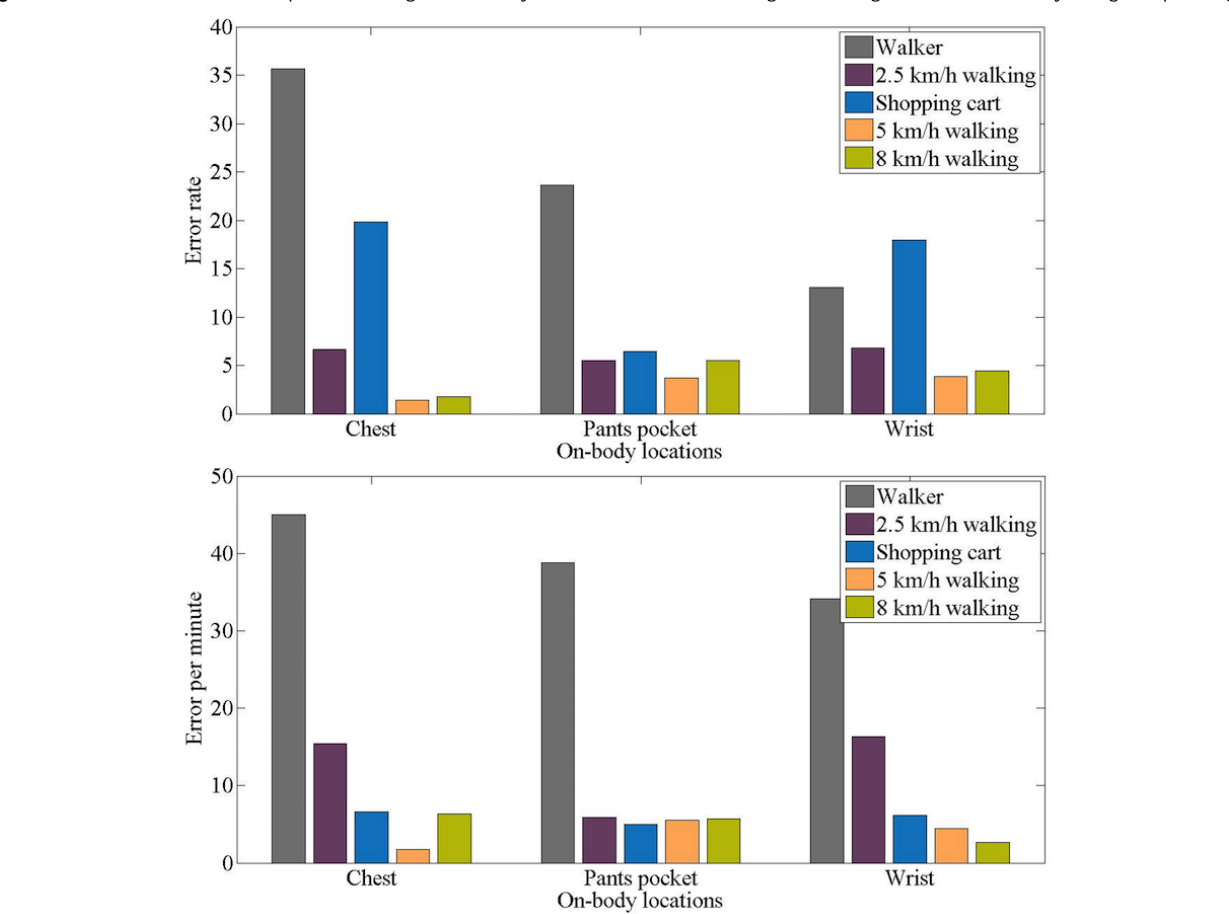
Figure 3. Error rate (left) and error per minute (right) of activity trackers in different wearing sites during the activities of daily living except